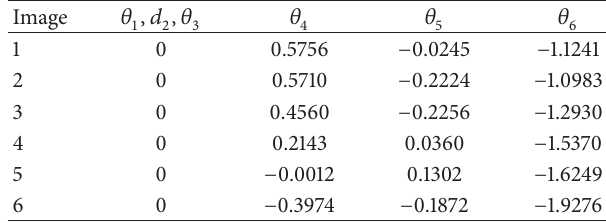
Table 4: The known movements of the generalized